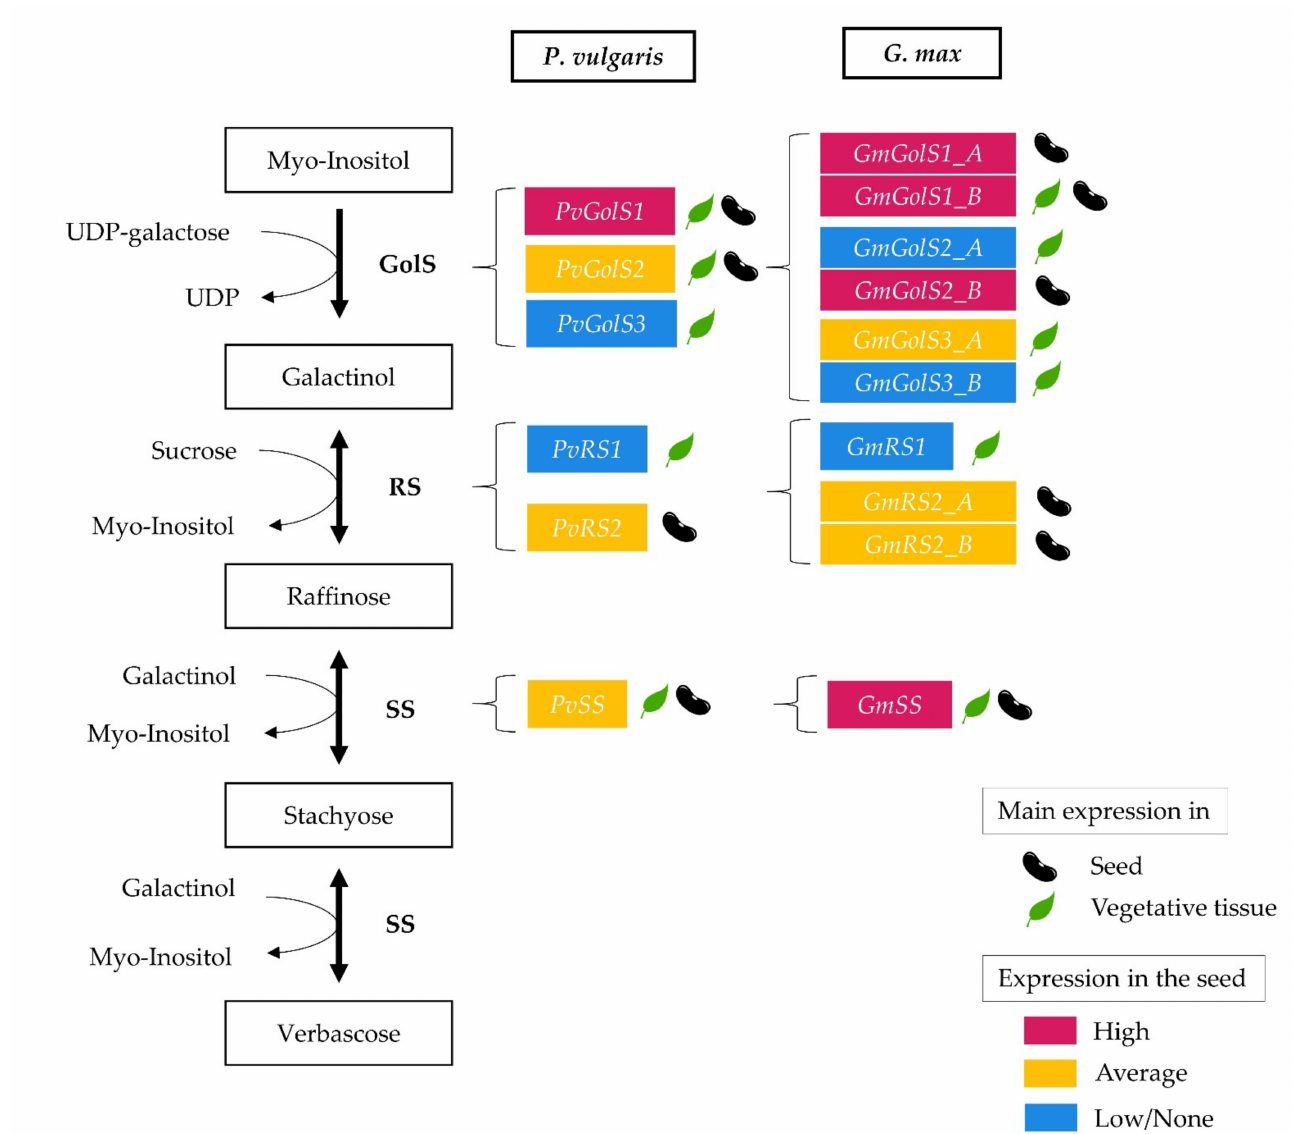
Figure 7. Overview of the RFO metabolic pathway and corresponding genes in P. vulgaris and G. max. The galactinol- and RFO synthase genes for P. vulgaris and G. max are shown to the right of the metabolic pathway. The main expression of these genes, either in the seed or the vegetative tissue, is indicated behind the gene names and the expression level of these genes in the seed are indicated in color, ranging from red (high), orange (average) to blue (low or no